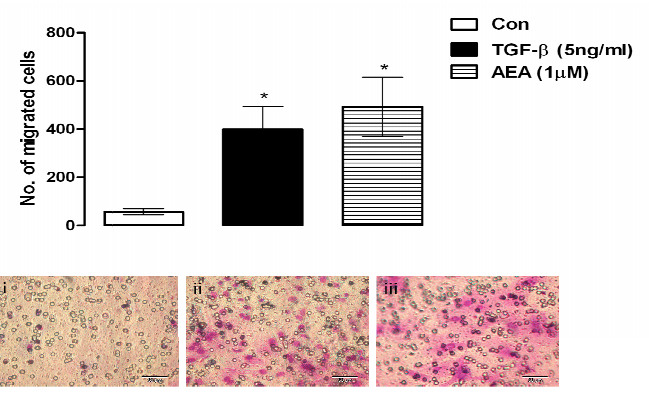
Figure 2. MSCs migrate towards the endocannabinoid anandamide. TGF